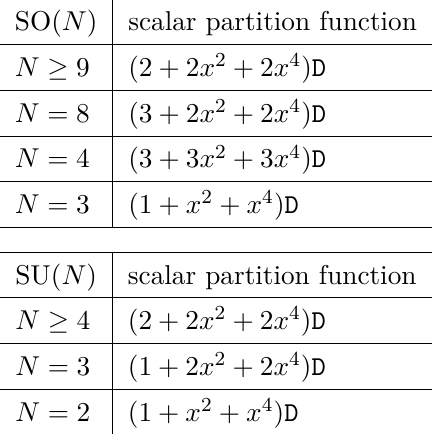
Table 3 . Partition function over the space of Lagrangians involving four Φ a ’s that are in the adjoint of SO( N ) and SU( N ) . This includes both parity even and parity odd Lagrangians. We have defined D ≡ 1 / ((1 − x 4 )(1 − x 6 ))